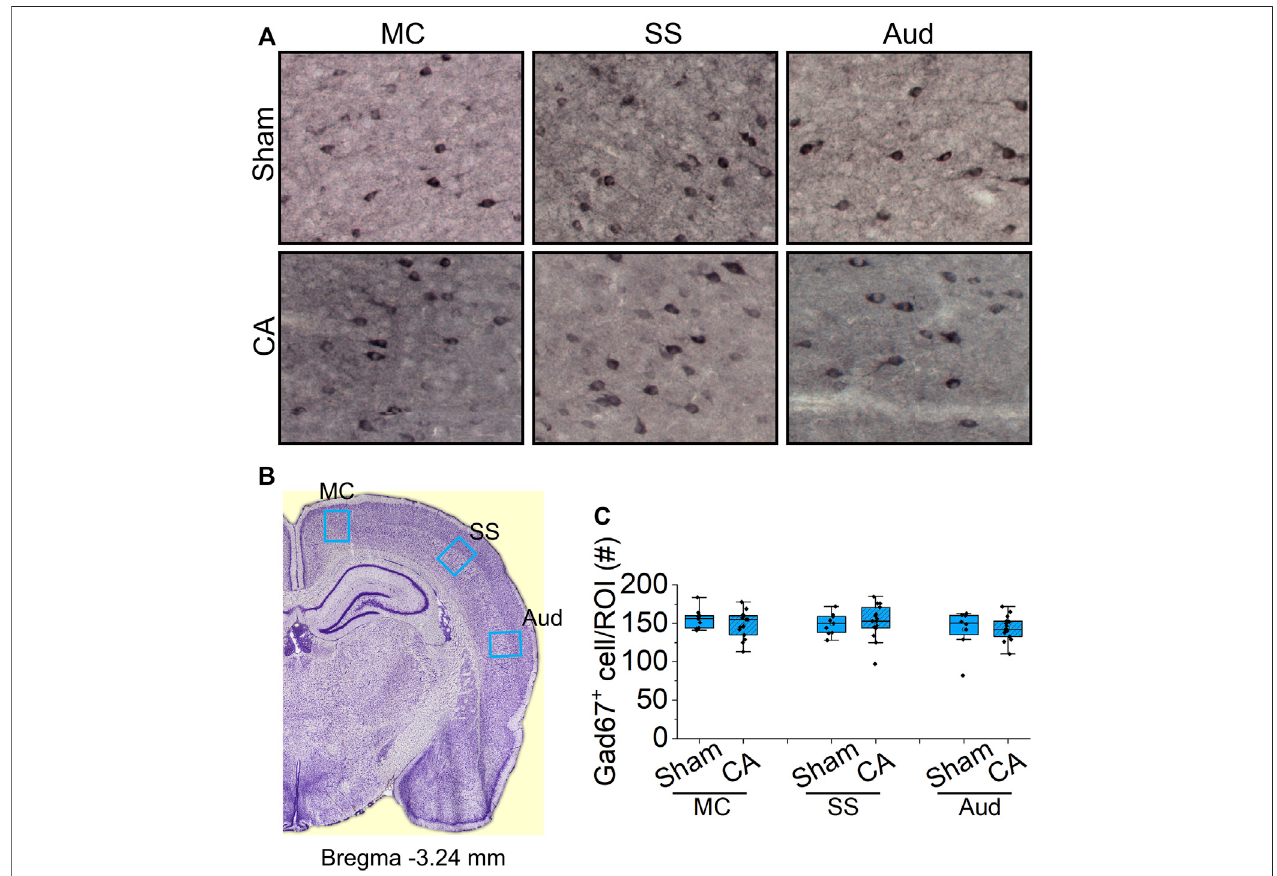
FIGURE8| AnalysisofGABA-ergicinterneuronsinthecortexofshamandCA (A) RepresentativeimagesofGad67staininginthesub-regionsofcortexfromsham (upper images) and CA (lower images) . Blue arrows indicate the Gad67-labelled cells counted manually using multi-point function in FIJI (B) Coronal sections at bregma 3.24 mm with regions of interest marked by blue boxes: motor cortex (MC), somatosensory cortex (SS), and auditory cortex (Aud) (C) The graphs show the numbers of Gad67-stained cell with median and interquartile range in the ROIs from three stained slides from three sham and 5 12.5 min CA animals. There is no signi fi cant deference in the number Gad67-labeled neurons between CA group compared with sham-operated group (Nested t -test, p > 0.05).